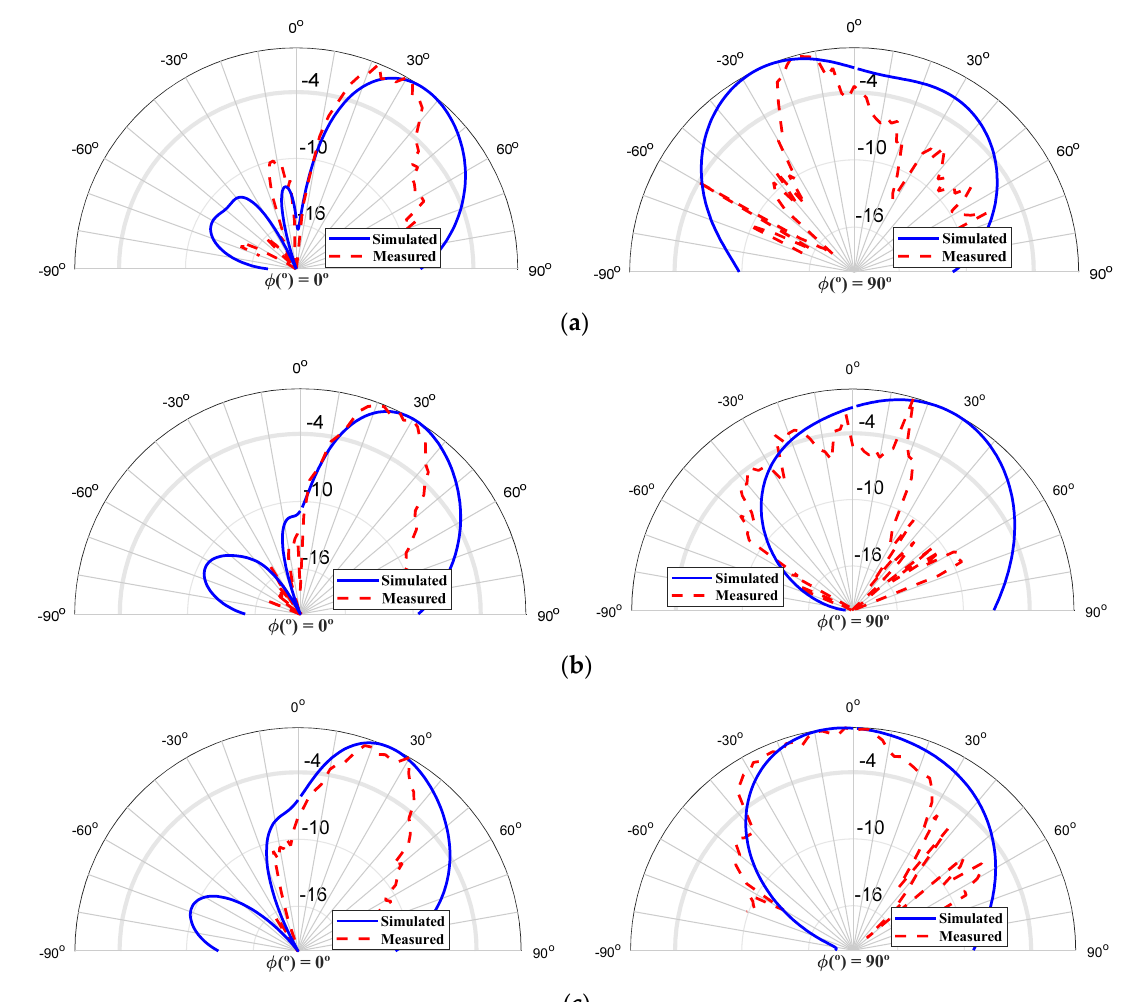
Figure 9. Radiation pattern of the 7-element log-periodic microstrip antenna array in the two main planes ϕ = 0° and ϕ = 90° for different frequencies: ( a ) f = 27 GHz, ( b ) f = 28 GHz, and ( c ) f = 29 GHz.